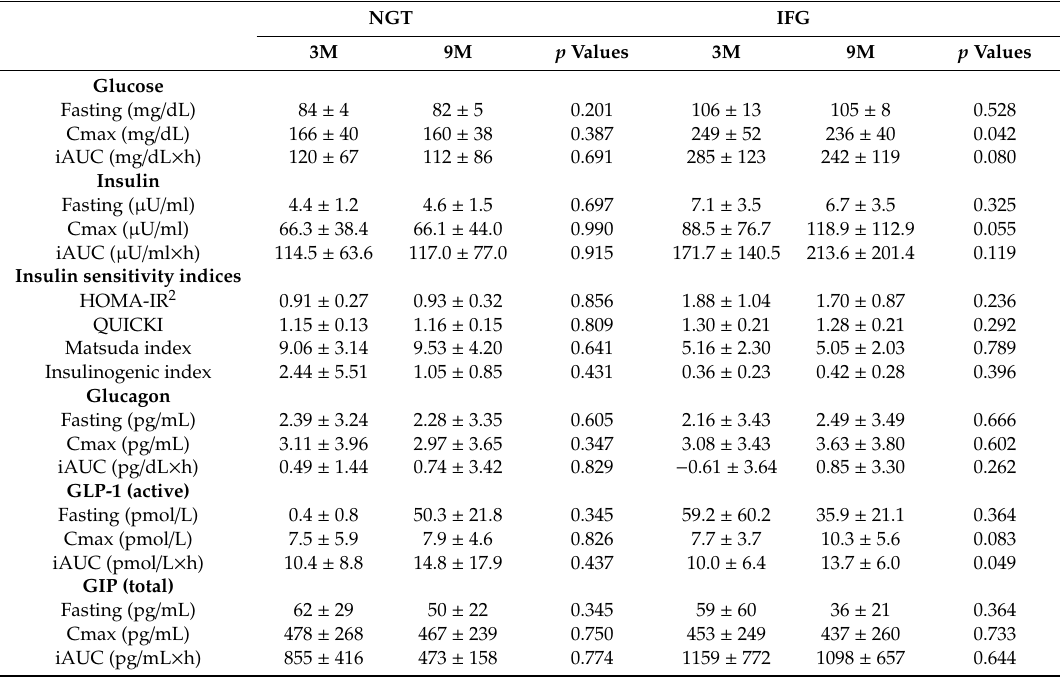
Table 3. Fasting and postprandial glucose, insulin, insulin sensitivity indices, glucagon, GLP-1, and GIP during the OGTT 1 .